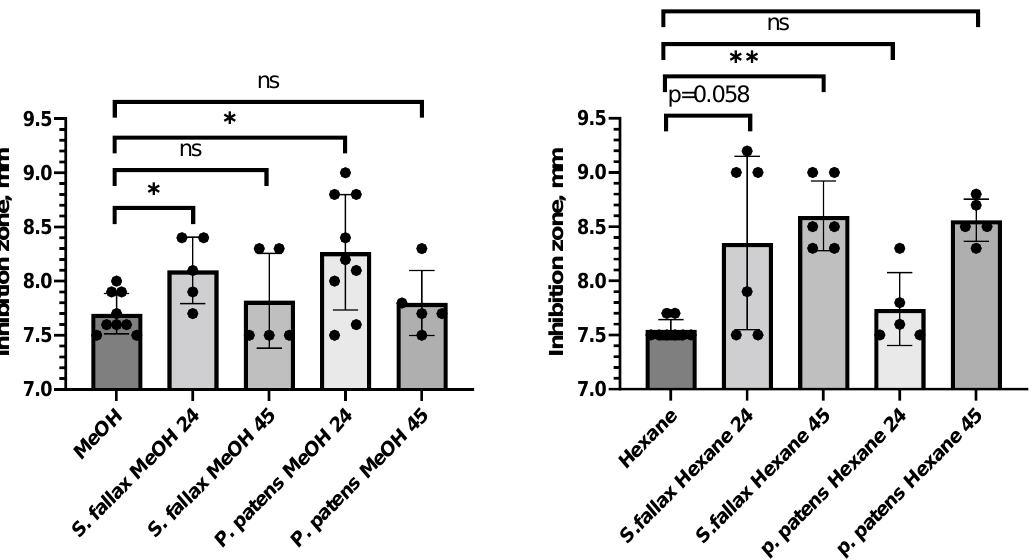
Figure 1. Polar and non-polar intracellular moss metabolites inhibit the growth of Pseudomonas syringae DC3000. The effect of intracellular fractions of S. fallax and P. patens mosses extracted with methanol (MeOH) ( left panel ) and hexane ( right panel ) on the growth of Gram-negative phytopathogenic P. syringae DC3000 was evaluated by the disk-diffusion assay (DDM); 80% methanol and hexane were used as negative controls. Moss metabolite extractions were performed for 24 or 45 h. Diameter of bacterial growth inhibition area (halo) around each cellulose disk containing moss metabolites was measured and plotted. Data represent the means from at least three independent experiments and a standard deviation. The asterisks indicate significance in an unpaired t -test; * —